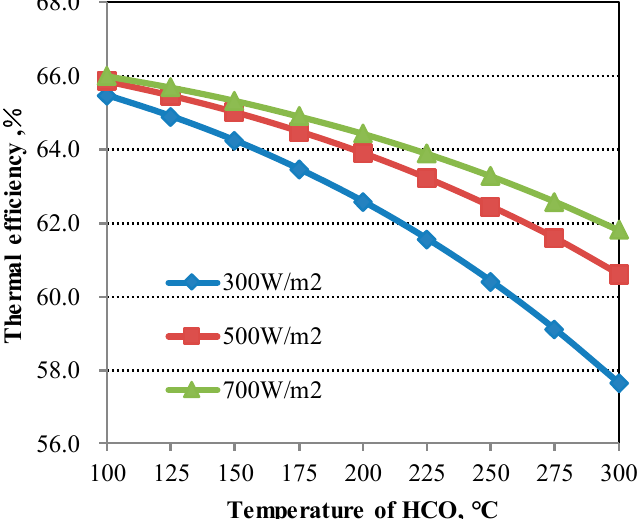
Figure 5. Variations in heat collecting efficiency of the LS-2 PTC with the different DNI and HCO temperature (the mass flow of the HCO is 47.8 L/min).